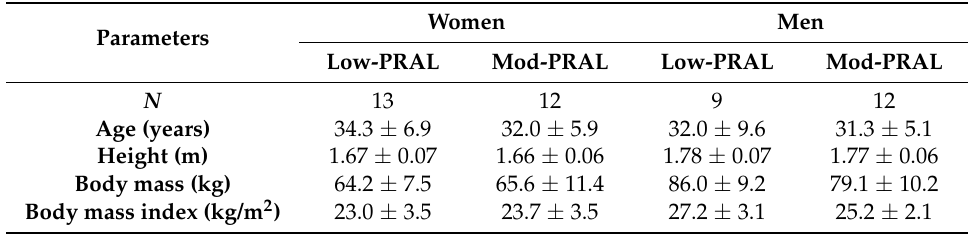
Table 1. Baseline anthropometric characteristics of the subjects in the low-potential renal acid load (PRAL) and moderate-PRAL diet